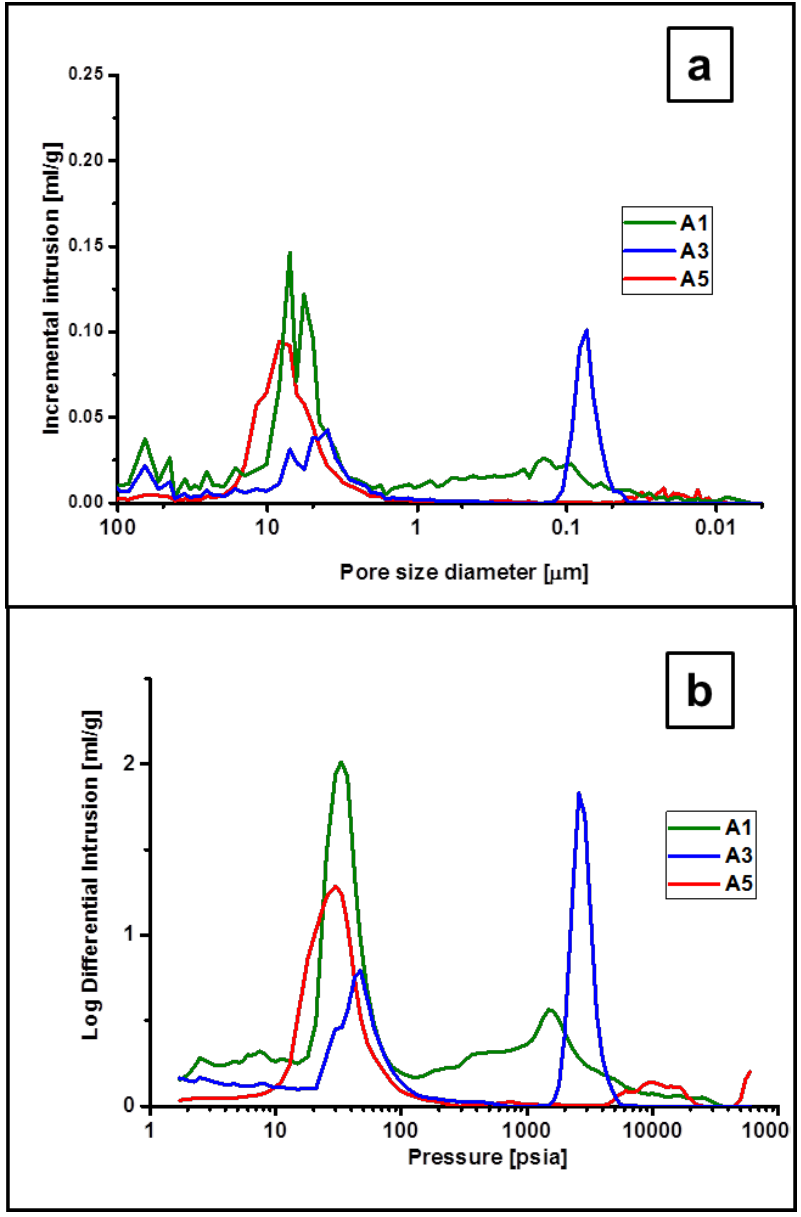
Figure 11. Mercury intrusion plots: ( a ) — Incremental intrusion vs. pore size, ( b ) — Log differential intrusion vs. pressure.